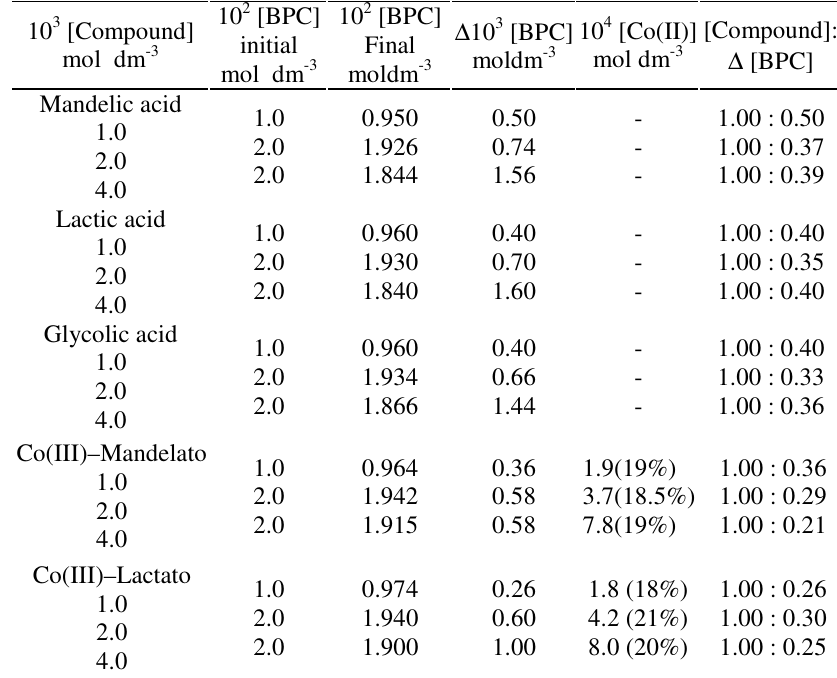
Table 2 . Stoichiometric data for BPC oxidation of Co(III) bound and unbound α -hydroxy acids in the presence of